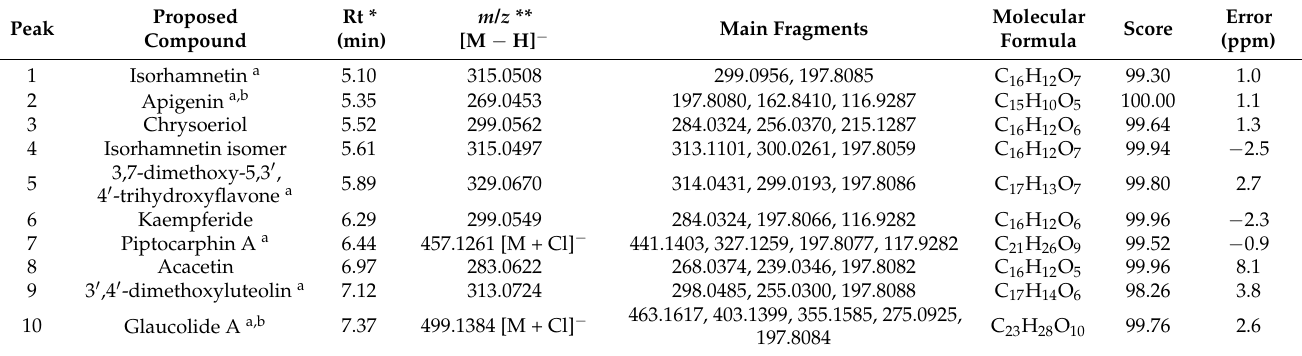
Table 1. Chemical characterization of V. polyanthes leaf rinse extract (Vp-LRE) by UHPLC-MS-QTOF.